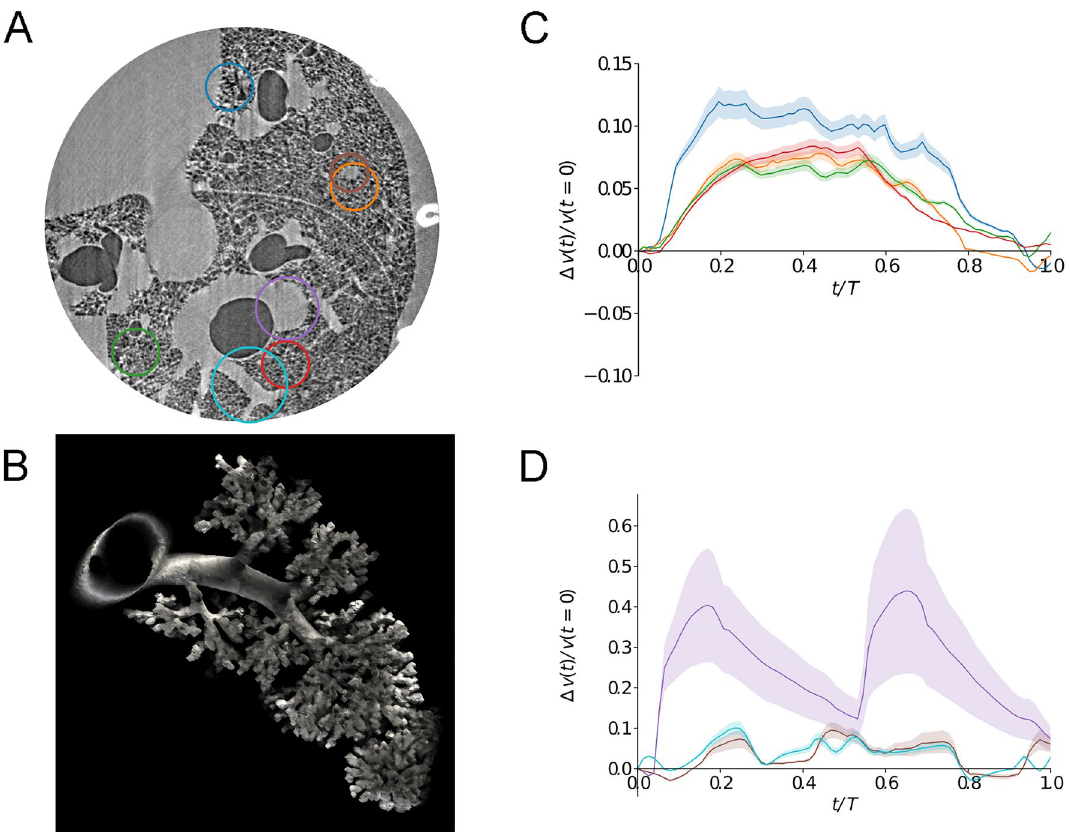
Figure 3. ( A ) X-ray phase-contrast CT image of live rat lung. Colored circles show regions of interest where regional biomechanics are computed; ( B ) a segmented airway with subtending conducting airways and terminal acinar structures at end-expiration in a live rat; ( C ) regional strain as a function of time computed within airspaces in the regions of interest of same color as in ( A ). The shaded area represents within-ROI standard deviation; ( D ) regional strain as a function of time ( t ), expressed relative to the total breath duration ( T ), computed within blood vessels in the regions of interest shown in ( A ). The shaded area represents within-ROI standard deviation. Note the typical pulse-wave deformation within the larger artery which is significantly damped in smaller caliber